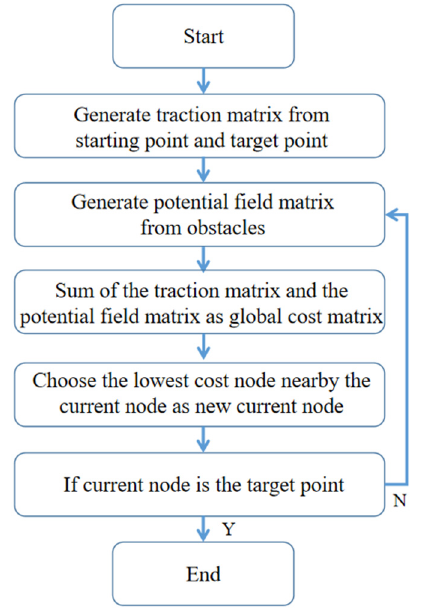
Figure 7. Flow chart of traditional artificial potential field route planning algorithm. The traditional artificial potential field method is